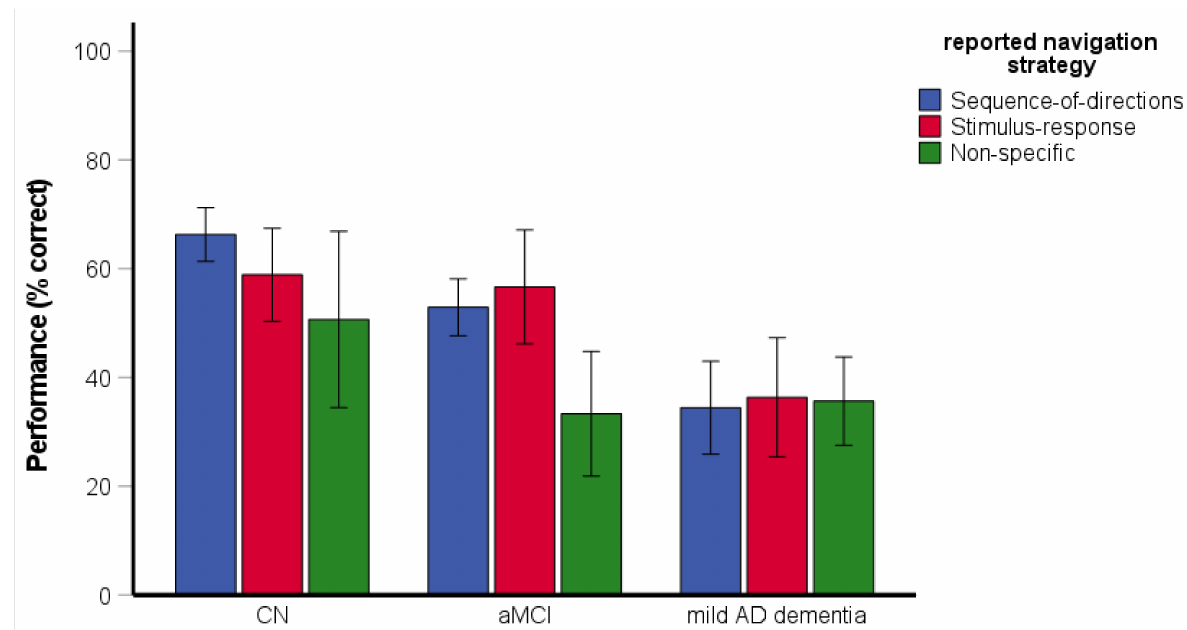
Figure 6. Route-retracing task—the effect of reported strategy on spatial navigation performance. CN, cognitively normal; aMCI, amnestic mild cognitive impairment; mild AD dementia, mild Alzheimer’s disease